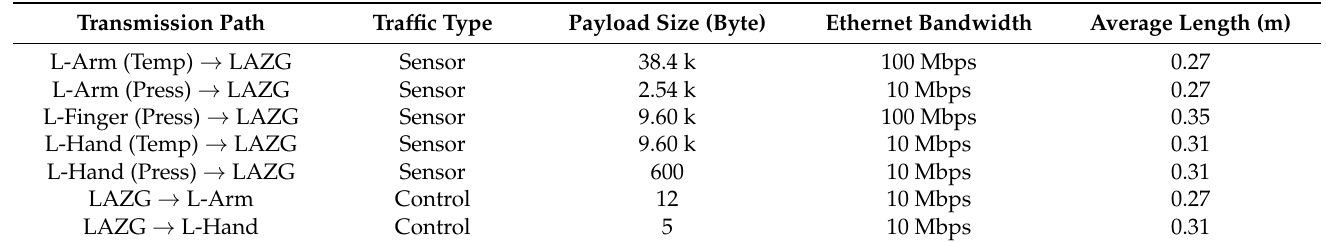
Table 6. Data transmission link parameters of the ZIRA Left Arm and Hand Zone.